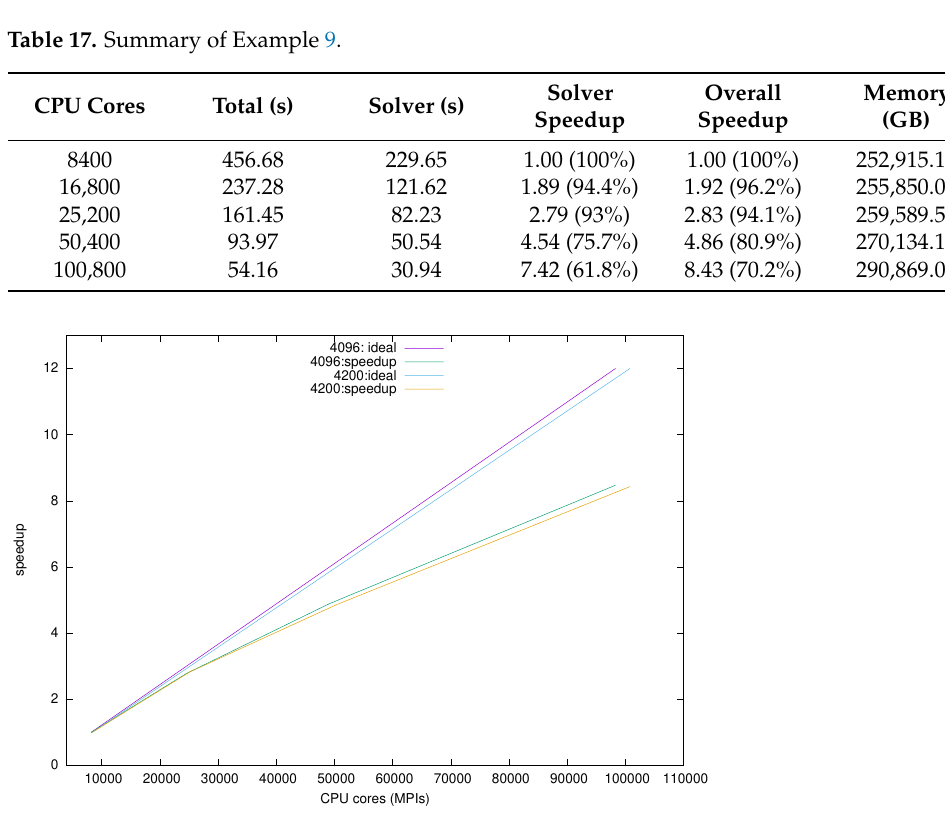
Figure 18. Example 9: scalability